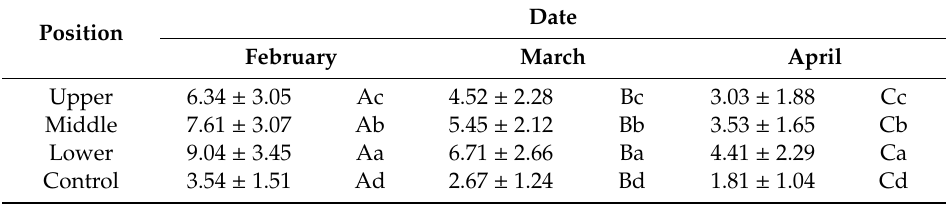
Table 5. Average SWC on the four positions evaluated in the three di ff erent dates of soil samples collection. The same lower-case letters on the columns and upper-case letters on the rows indicate that there is no statistic di ff erence between the means for the t test by the level of 5% of probability.